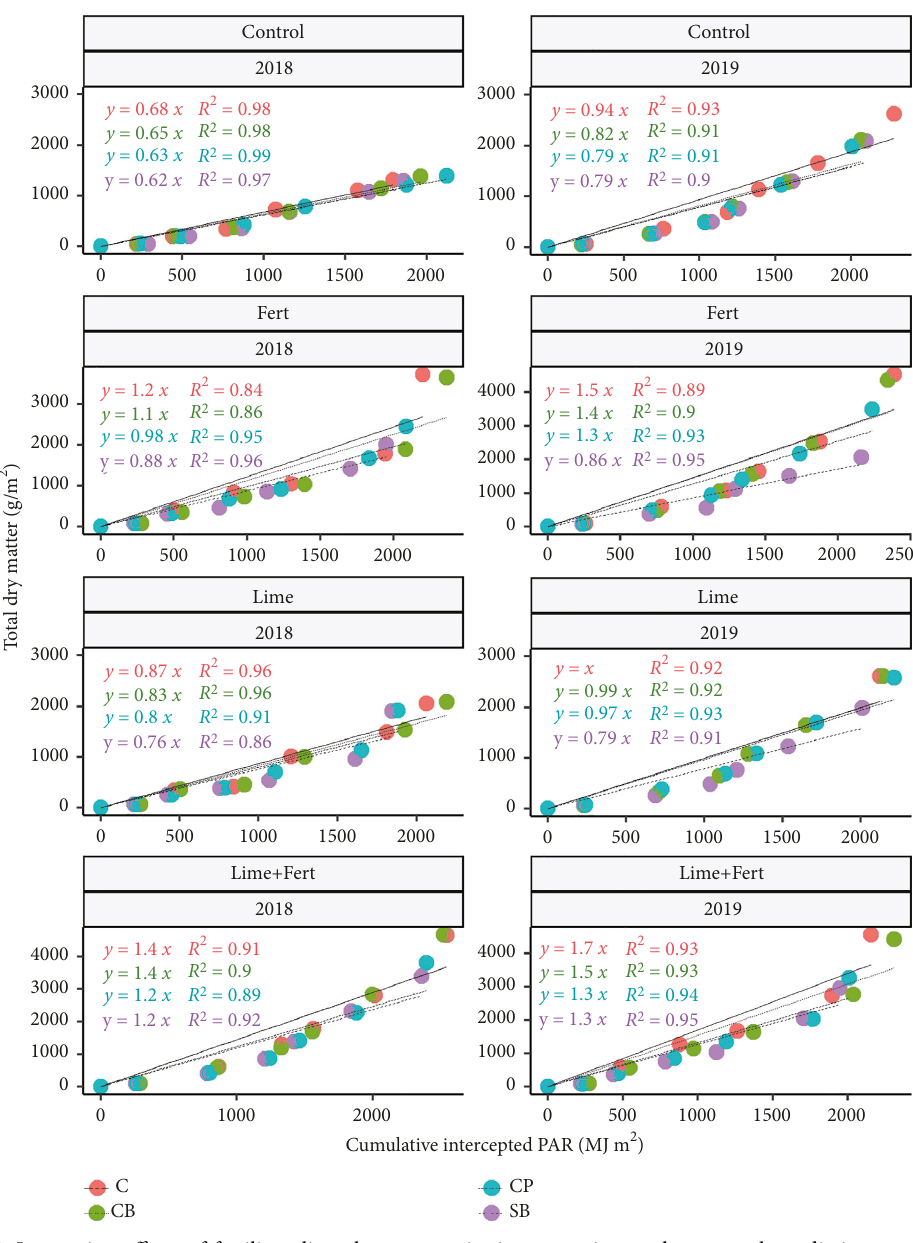
Figure 4: Interaction effects of fertilizer, lime, legume species intercropping, and year on the radiation-use